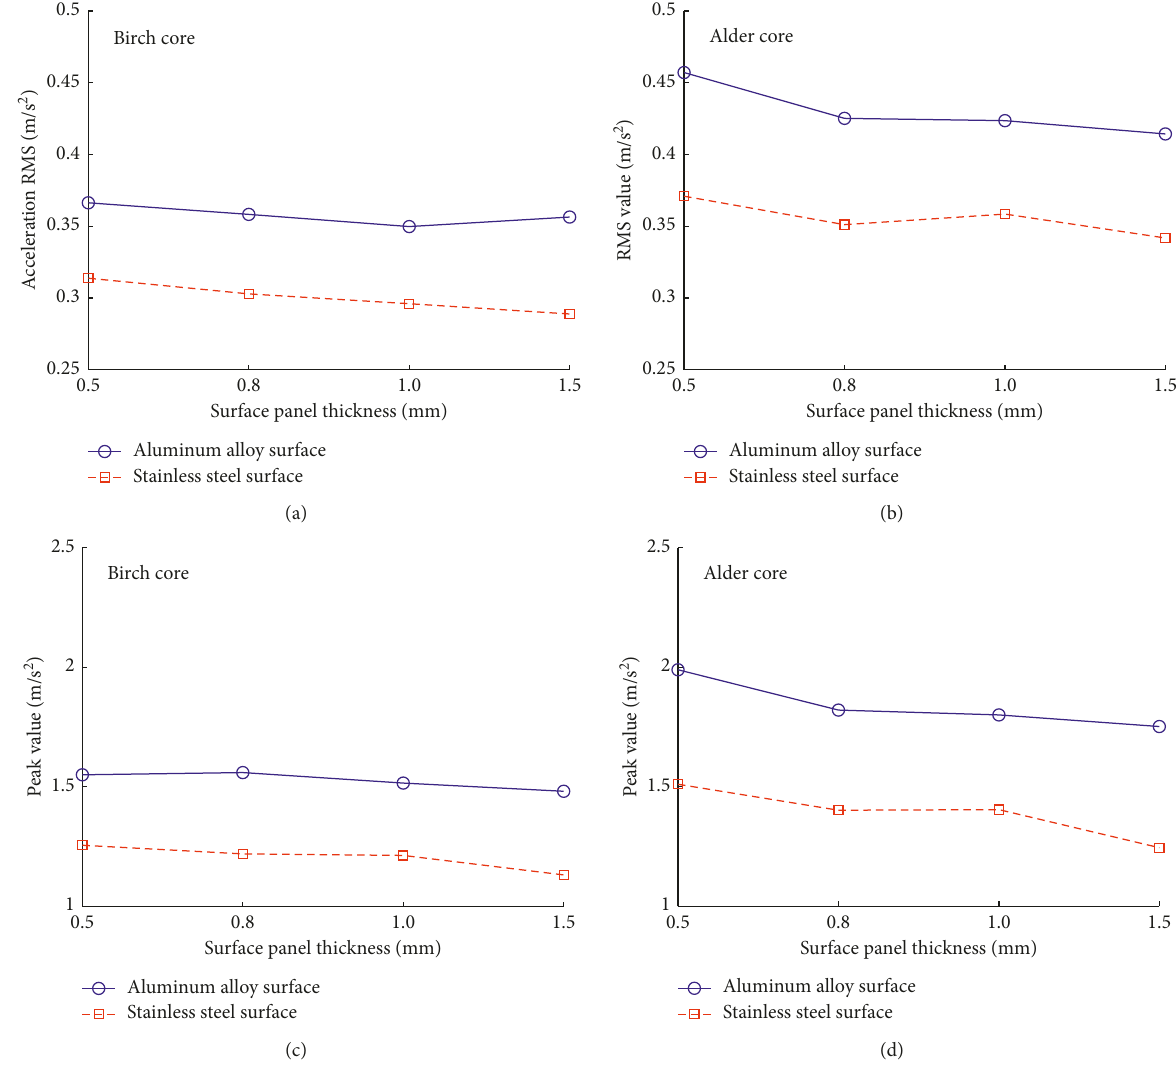
Figure 12: Time domain results of vibration acceleration response. (a) Vibration RMS value of birch core panels. (b) Vibration RMS value of alder core panels. (c) Vibration peak value of birch core panels. (d) Vibration peak value of alder core